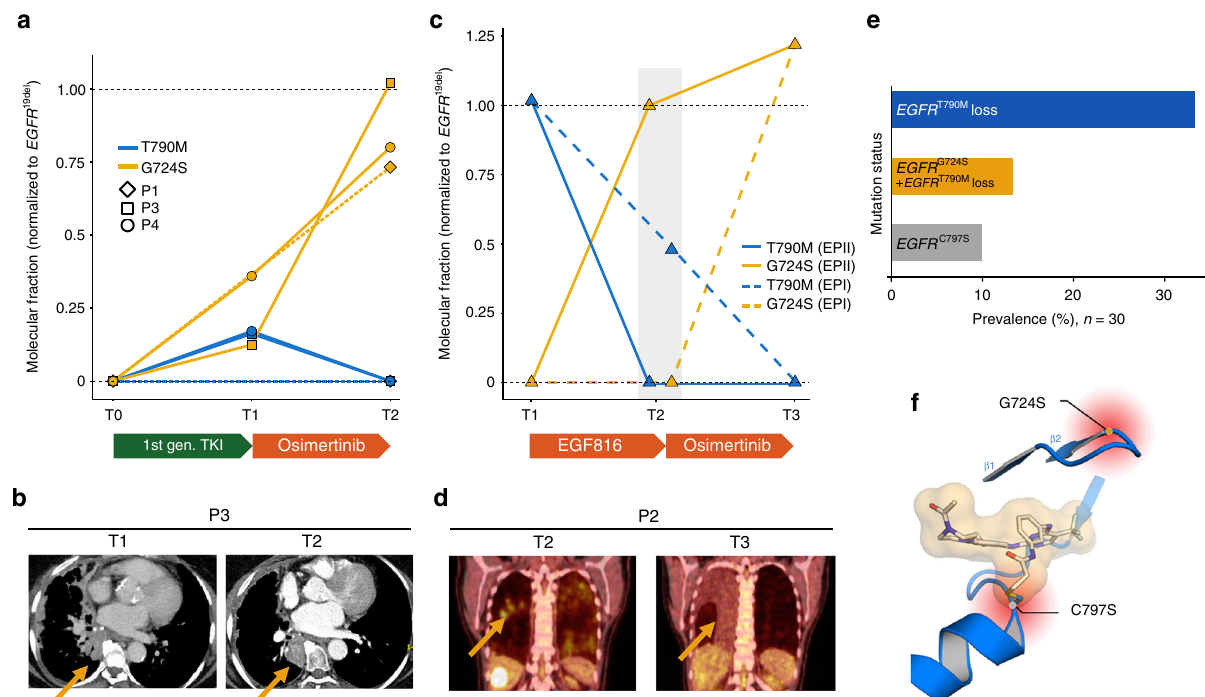
Fig. 1 Insight into patient ’ s examination results and prevalence of EGFR resistance mutations. a Graph showing the molecular fractions of EGFR T790M and EGFR G724S normalized to EGFR 19del at fi rst diagnosis (T0), prior to treatment with osimertinib (T1) and at progression to osimertinib (T2) in patients P1, P3, and P4. Treatment is indicated with bars below. All patients received a fi rst-generation EGFR inhibitor (1st gen. TKI) prior to treatment with osimertinib. In P1, next-generation sequencing was not feasible at T1 and EGFR status was determined by Sanger sequencing (dotted lines). b The contrast-enhanced CT scans of patient P3 prior to treatment with osimertinib (T1) and at progression (T2) are exemplarily shown. The yellow arrows mark the spot of the biopsy collected in a growing lesion. c Prior to the start of osimertinib treatment (T2) two separate biopsies were collected (EPI, dotted line and EPII, solid line). Graph indicates the evolution of the molecular fractions of EGFR T790M and EGFR G724S in patient P2 prior to treatment with EGF816 (T1) and osimertinib (T2) and at progression to osimertinib (T3). d 18 FDG PET-CT scans shows P2 prior to treatment (T2) and at progression to treatment with osimertinib (T3). e Bar chart showing the frequencies of EGFR mutations ( EGF R G724S and EGFR C797S ) at progression to third-generation EGFR inhibition ( n = 30). f Positions of the osimertinib resistance mutations EGFR C797S and EGFR G724S within the binding site of the EGFR kinase domain are shown (PDB